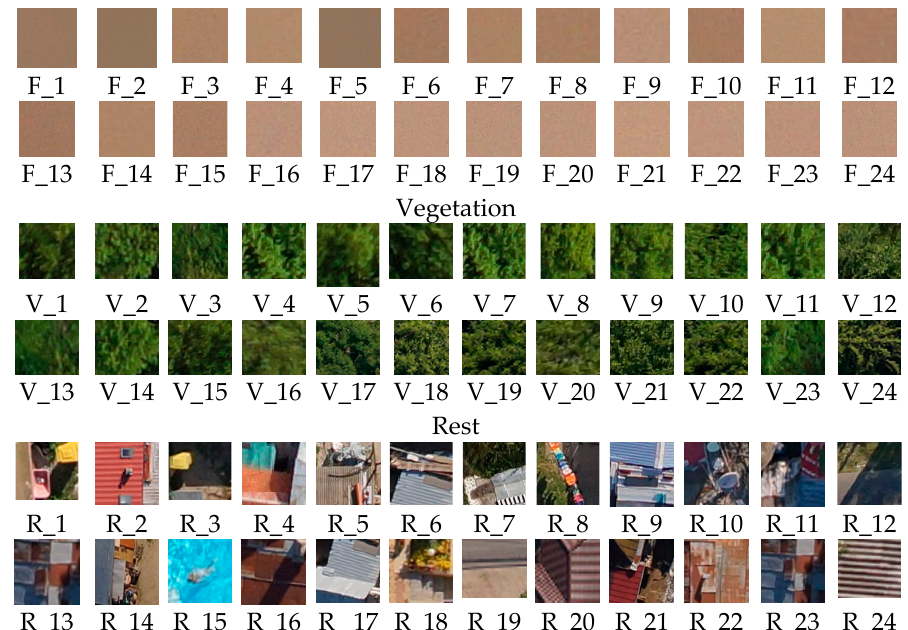
Figure 13. Examples of patches for flood (F), vegetation (V), and rest (R) for learning phase (our dataset).